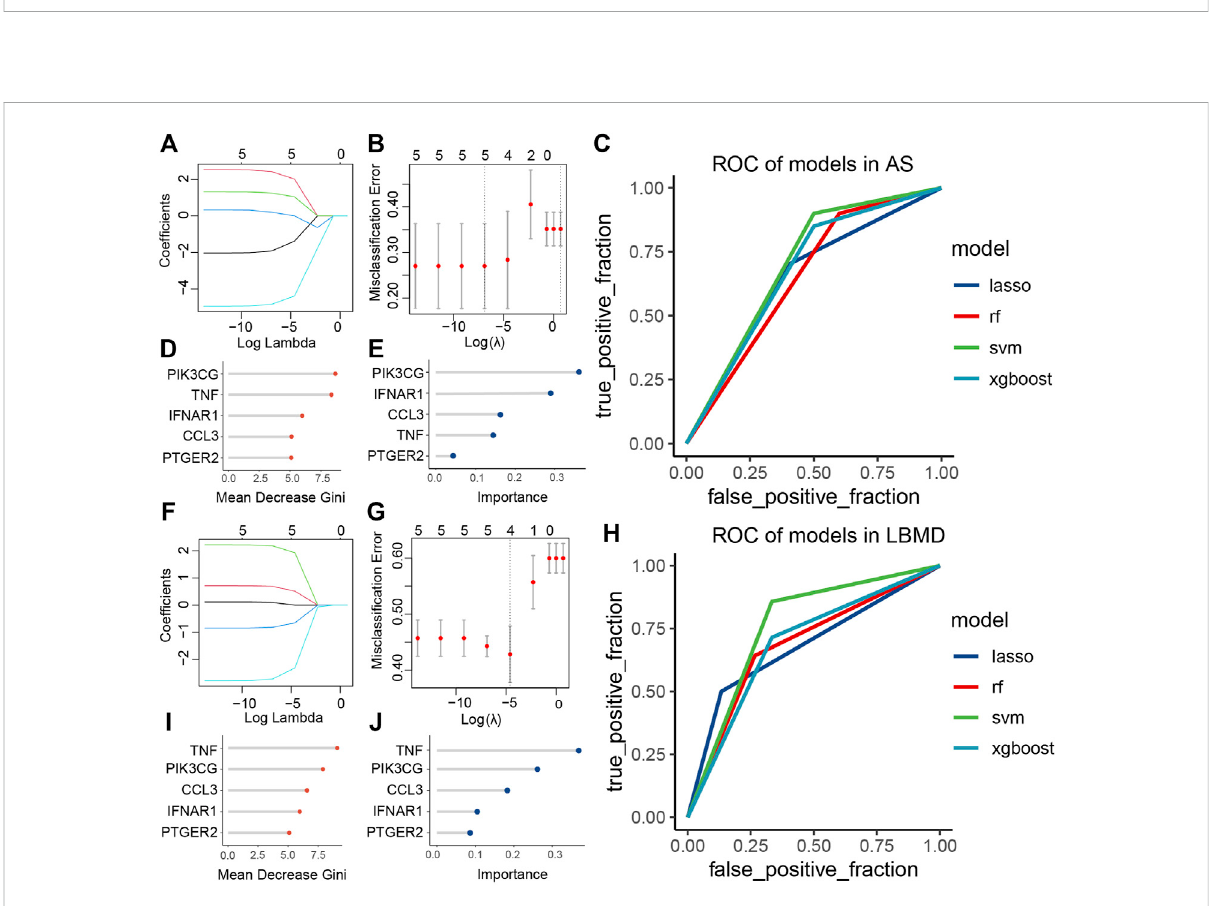
FIGURE 8 (A) LASSO regression of fi ve genes in AS; (B) Cross-validation for tuning the parameter selection in the LASSO regression of AS; (C) ROC curve analysisofmodelsinAS; (D) TheimportanceofeachfeatureinRFofAS; (E) TheimportanceofeachfeatureinXGBoostofAS; (F) LASSOregressionof four genes in LBMD; (G) Cross-validation for tuning the parameter selection in the LASSO regression of LBMD; (H) ROC curve analysis of models in LBMD; (I) The importance of each feature in RF of LBMD; (J) The importance of each feature in XGBoost of